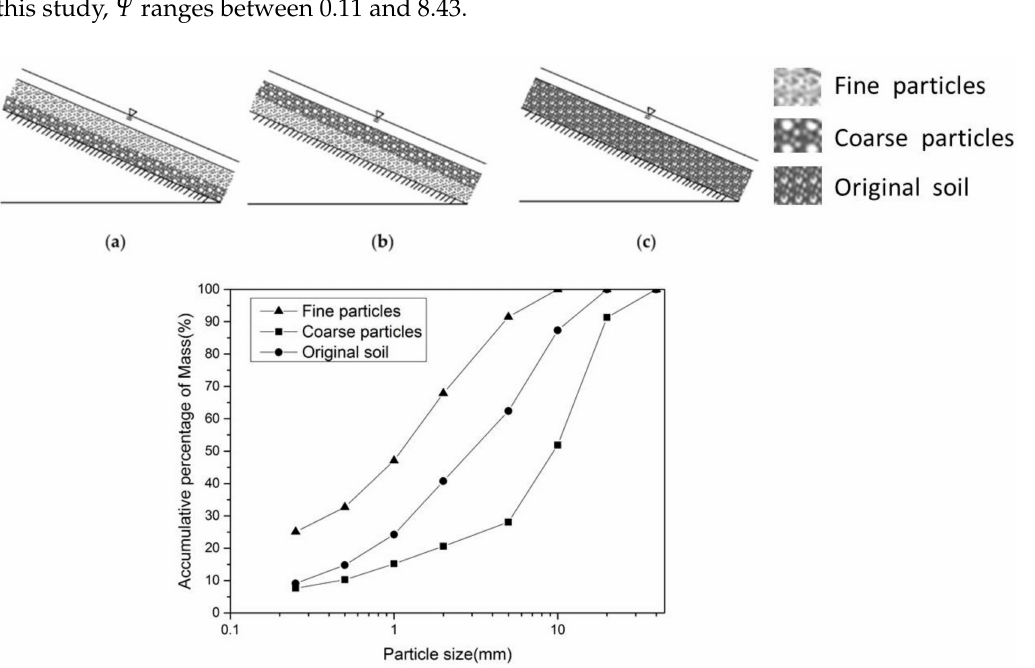
Figure 1. Particle size distribution curves typical of the material used for this study and schematic representation of the vertical distribution of coarse and fine particles within three experimental debris configurations. ( a ) normal grading with Ψ = 0.11; ( b ) inverse grading with Ψ = 8.43; ( c ) homogeneous grading pattern with Ψ =